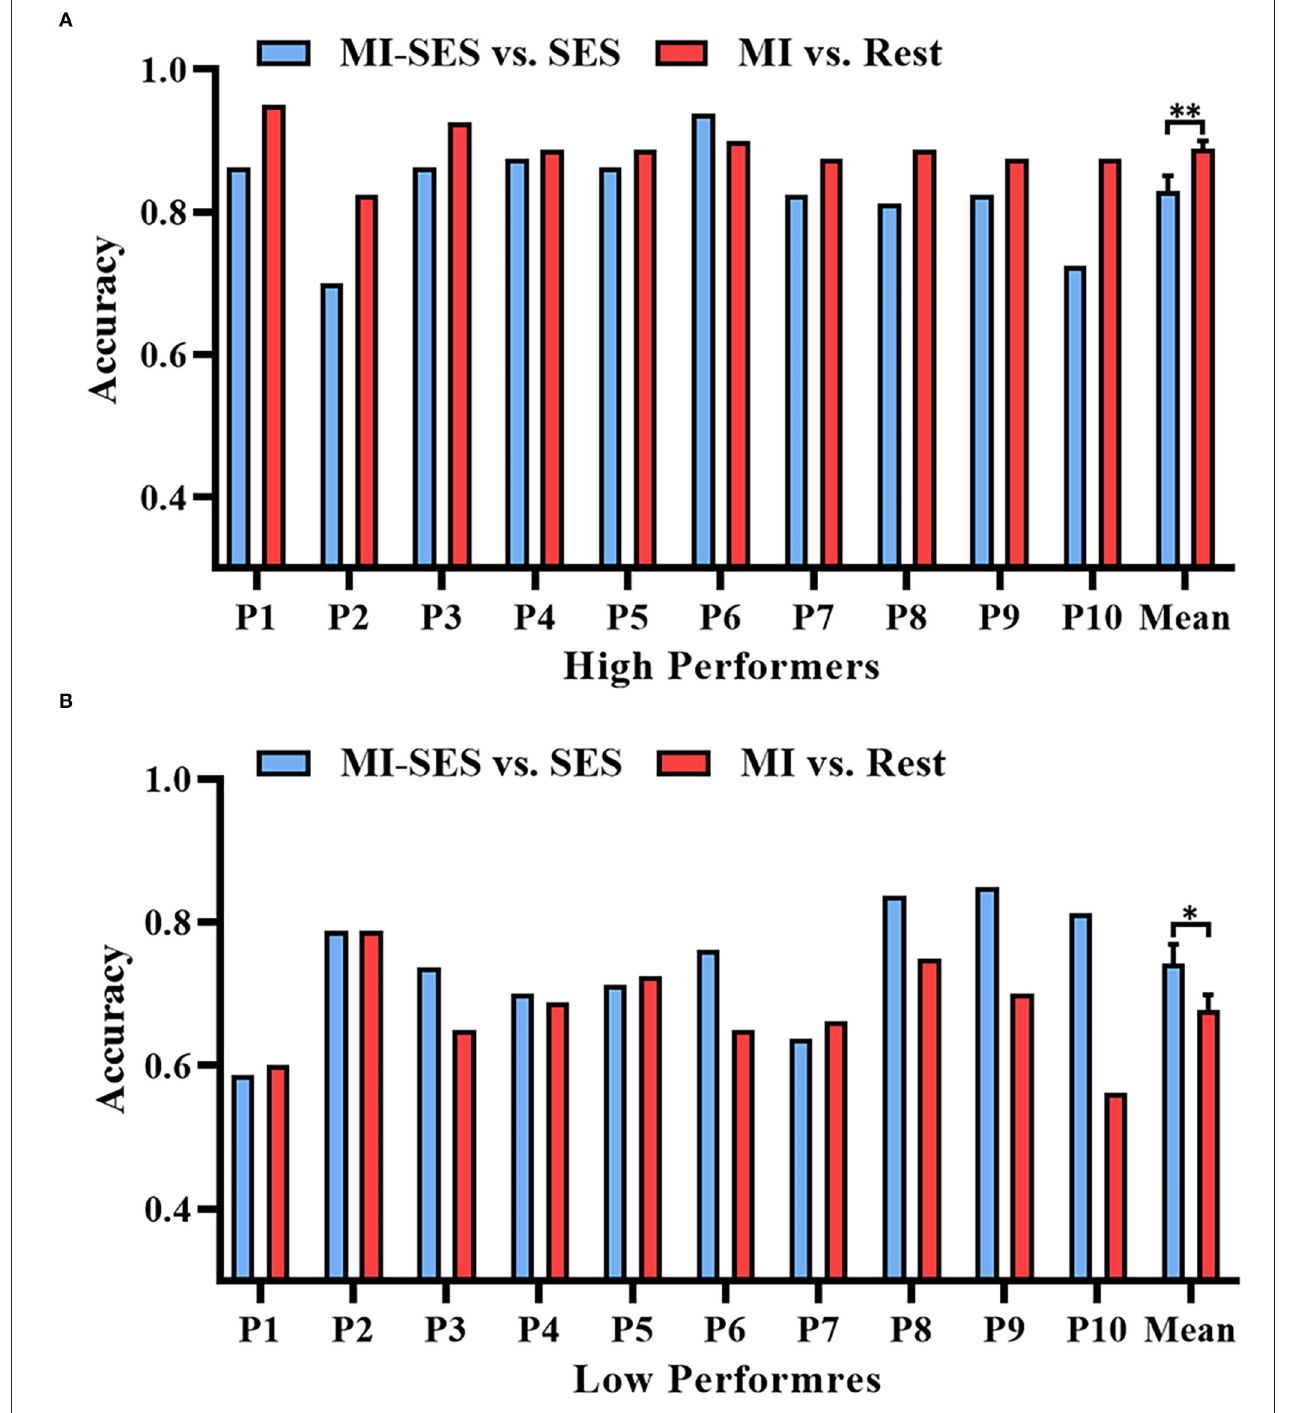
FIGURE 2 | Offline accuracies of brain-switch BCI with or without st-SES modulated. (A) Classification accuracy results in High Performers group. (B) Classification accuracy results in Low Performers group. Error bars represent standard error of mean. “*” indicates p < 0.05, “**” indicates p < 0.01.